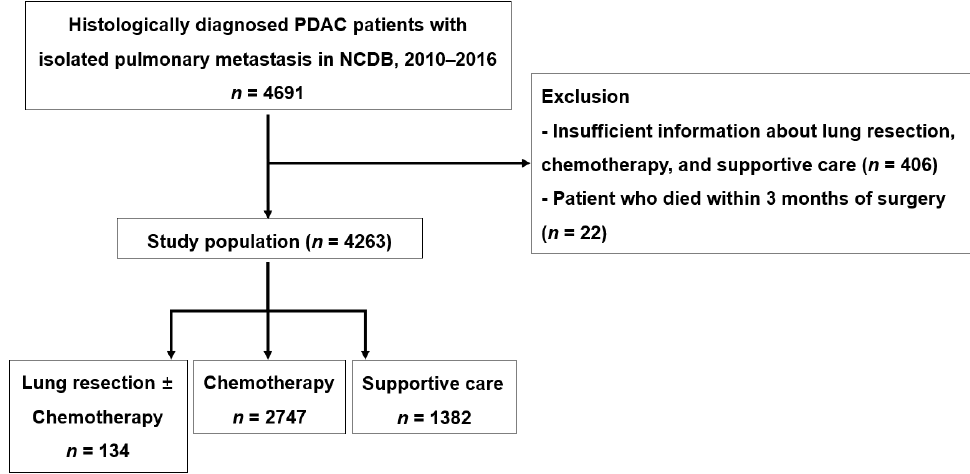
Figure 2. National Cancer Database mining strategy.